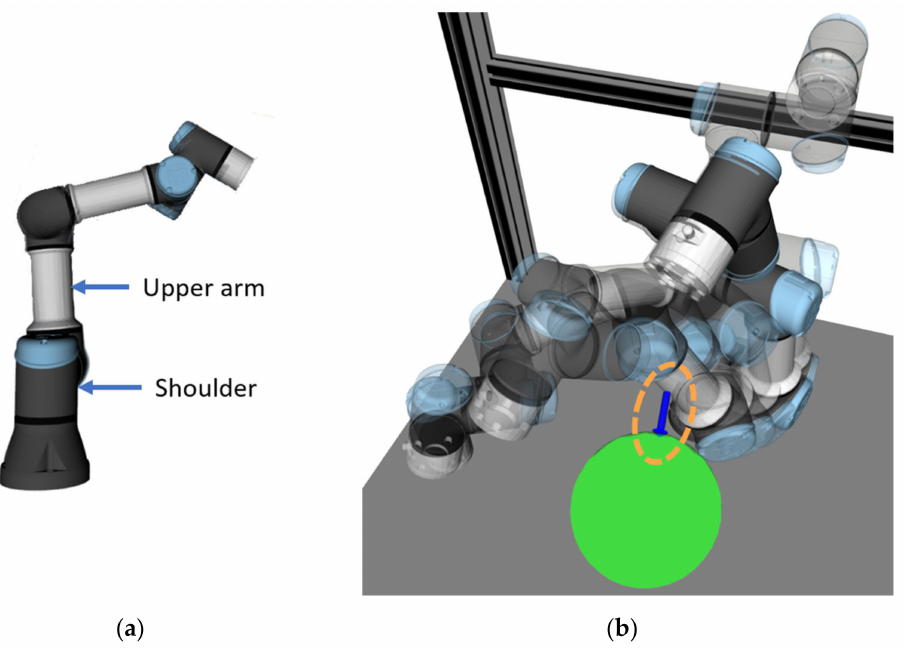
Figure 21. Collision vector computed during movement of the robot to the first goal position: ( a ) names of the related robot links; ( b ) collision vector starting from upper arm of the